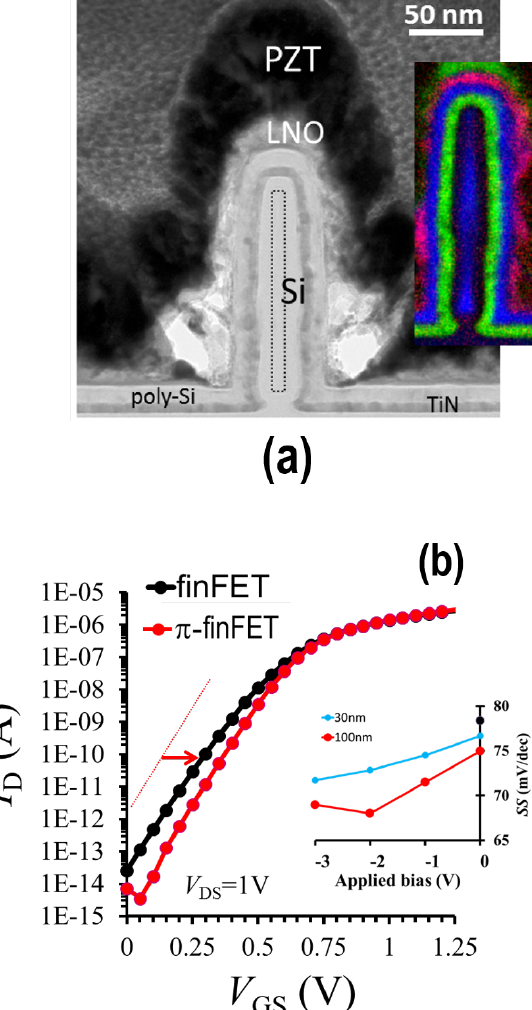
Figure 6. ( a ) High-resolution transmission electron microscopy (HR-TEM) image (incl. an red-green- blue (RGB) map: La is red, Ti is green, and Si is blue) of one fin of a silicon π -FinFET with a 20 nm fin width, and a 10 nm LNO (lanthanum-nickelate) and 100 nm PZT layer stack. The LNO layer is a buffer layer to avoid ferroelectric performance degradation of the PZT layer and atom interdiffusion through interfaces. The fin height is around 150 nm. In addition to the 10 nm LNO layer the gate stack comprises a 12 nm poly-Si, 10 nm SiO 2 and 6 nm TiN (gate metal). ( b ) Current-voltage ( I D - V GS ) characteristics of the π -FET compared to that of the conventional counterpart. Note that the π -FET curve has been shifted to match the I ON ( ∆ V GS ≈ 0.2 V). The inset shows the measured SS value against the (separate) bias over the π -layer for two different fin widths (30 and 100